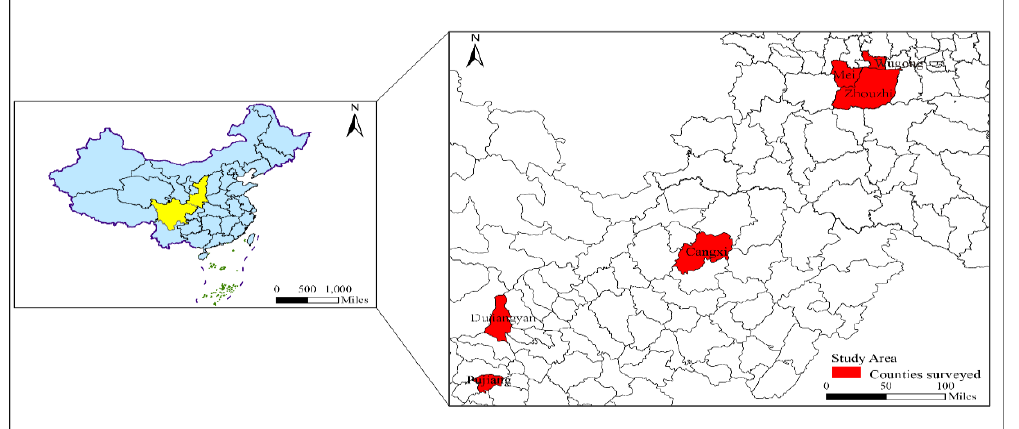
Figure 1. Map of the surveyed regions.